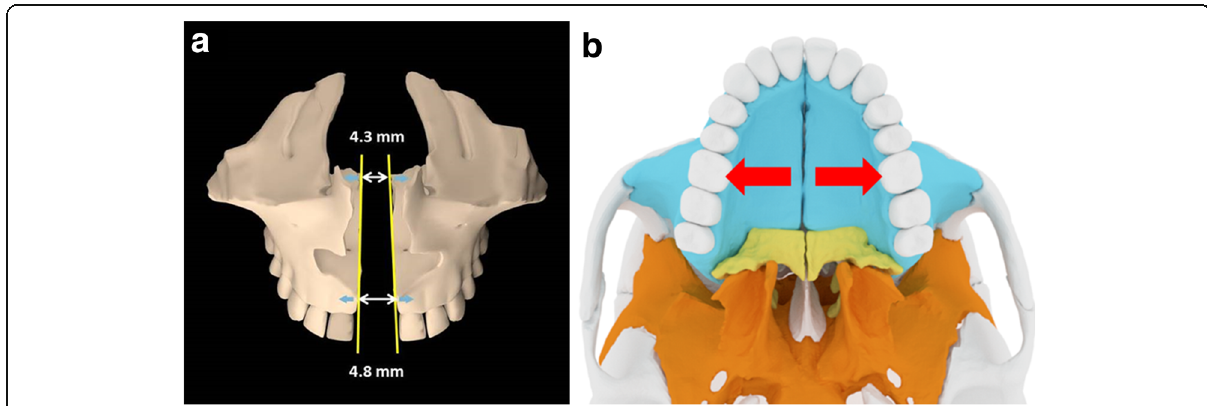
Fig. 10 Sagittal parallelism of midpalatal suture opening obtained with MSE. a Borders of the midpalatal suture (yellow lines) moving almost perfectly parallel to each other; amount of split at PNS (4.3 mm) was 90% of that at ANS (4.8 mm). b Position of MSE in the posterior part of the palate, providing an expansion force (red arrows) in line with the zygomatic buttress bones, which represent a major resistance to the movement of maxillary